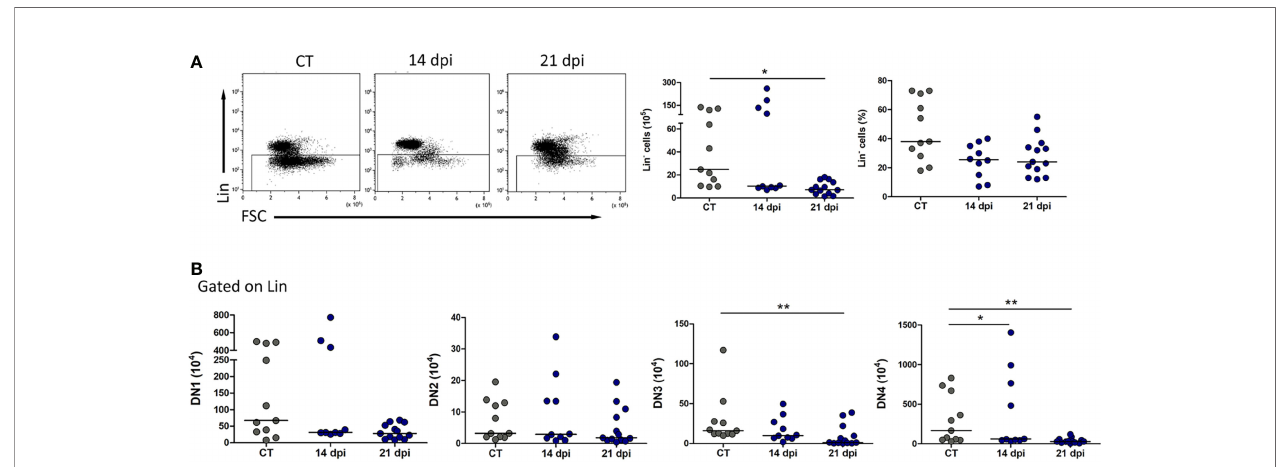
FIGURE 6 | Decrease in the relative numbers of CD4 − CD8 − immature thymocyte subsets following Trypanosoma cruzi acute oral infection. (A) Decreased absolute (but not relative) numbers of Lin − population. (B) Within the Lin − compartment, DN thymocytes were followed by immunostaining with CD25 and CD44. In late oral T. cruzi infection, the absolute numbers of virtually all DN subsets (except for DN2 cells) were signi fi cantly decreased in late days post-infection. The data are representative of 2 experiments with 3 – 5 animals per group at 14 and 21 dpi. Statistical differences were ascertained with the non-parametric, Kruskal – Wallis